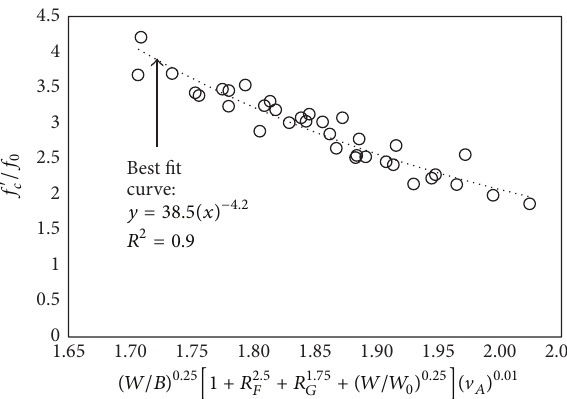
Figure 3: Regression analysis for 𝑓 󸀠 𝑐 of high-volume SCM concrete.